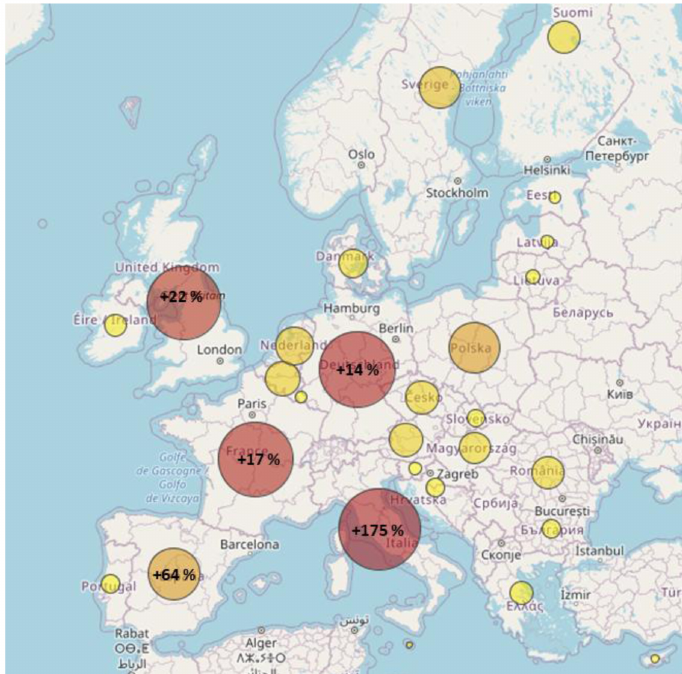
Figure 5. Heat pump demand repartition in the sensitivity and comparison with the reference scenario.